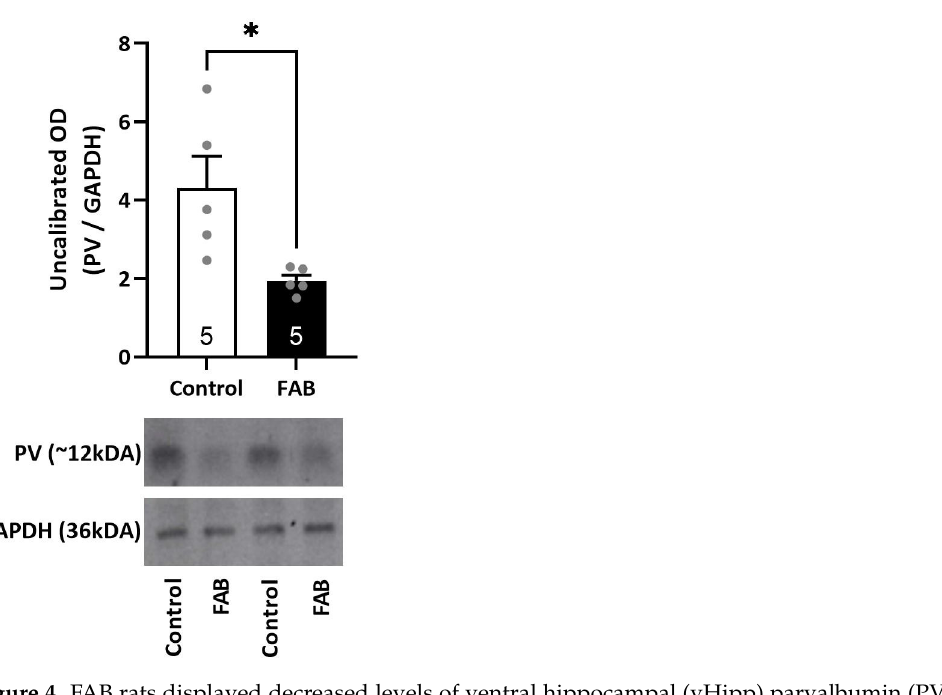
Figure 4. FAB rats displayed decreased levels of ventral hippocampal (vHipp) parvalbumin (PV). Representative Western blot films demonstrating PV and GAPDH levels in control and FAB rats. * p = 0.008.